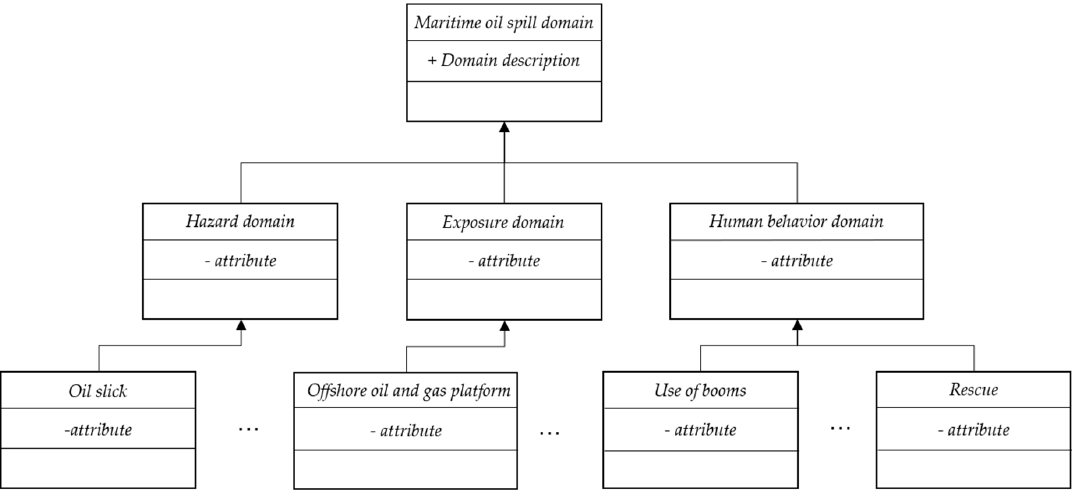
Figure 4. Object ‐ oriented (OO) ‐ based structure of the marine oil spill domain . Figure 4. Object-oriented (OO)-based structure of the marine oil spill domain